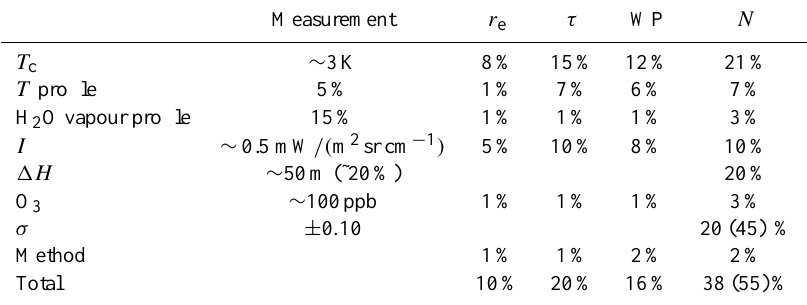
Table 2. Typical 95% confidence retrieval errors for liquid and (ice) cloud r e , τ , WP and N based on combined measurement and retrieval